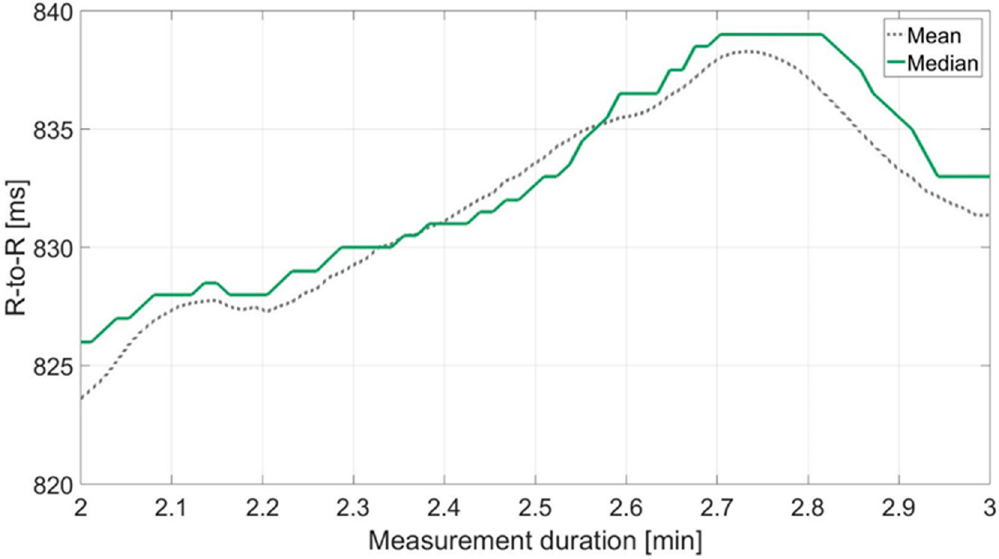
Figure 3. Exemplary comparison of RR interval (R-to-R) (ms) measurements prepared with mean vs. median over 60 s ( n = 72 measured values).